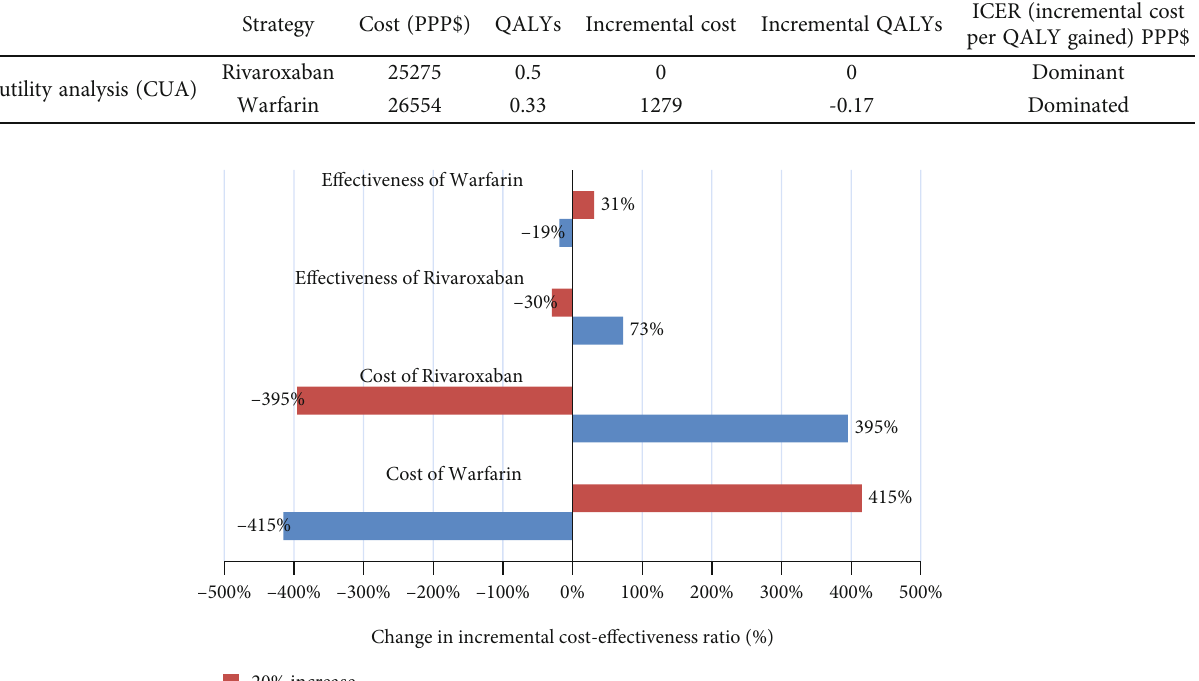
Table 4: Results obtained from comparison of cost-utility of two treatment methods for atrial fi brillation patients. Strategy